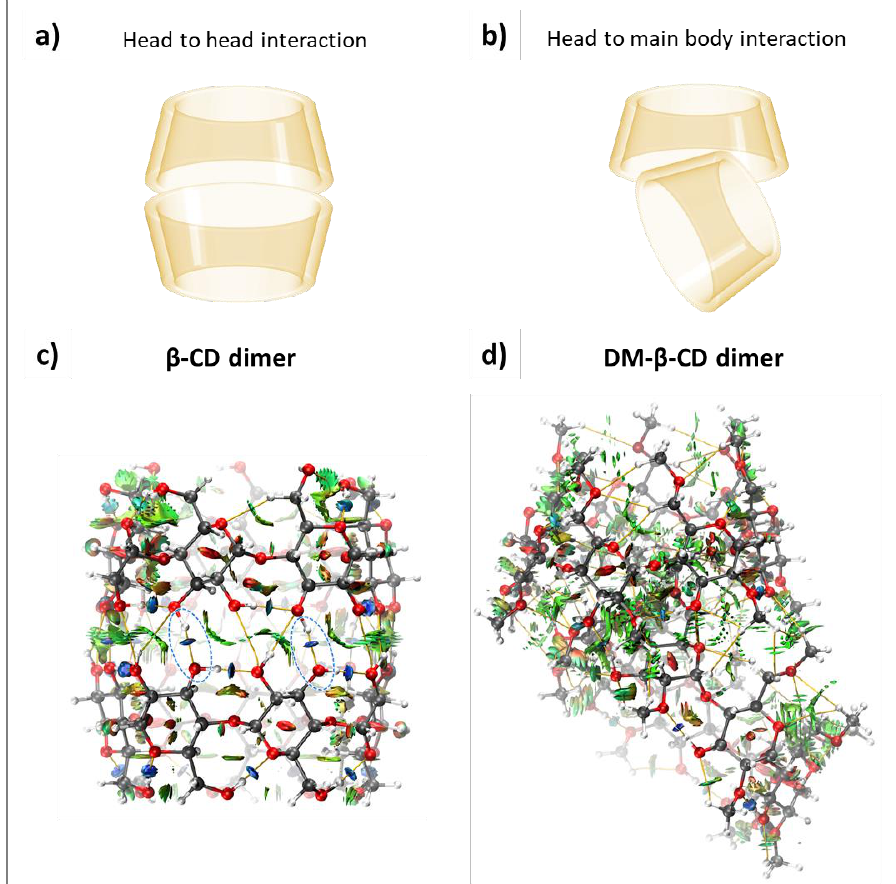
Figure 4. Schematic of ( a ) head-to-head interactions and ( b ) head to main body interactions of β -CD and DM- β -CD dimers, respectively. Color-filled RDG isosurface for intermolecular host-host interactions between ( c ) β -CD dimers and ( d ) DM- β -CD dimers. The different types of interaction regions are highlighted in different colors, blue: attractive interactions (hydrogen bonds), green: slightly attractive vdW interactions, red: repulsive steric interactions. Hydrogen bonds are additionally marked with blue, dashed ellipsoids.